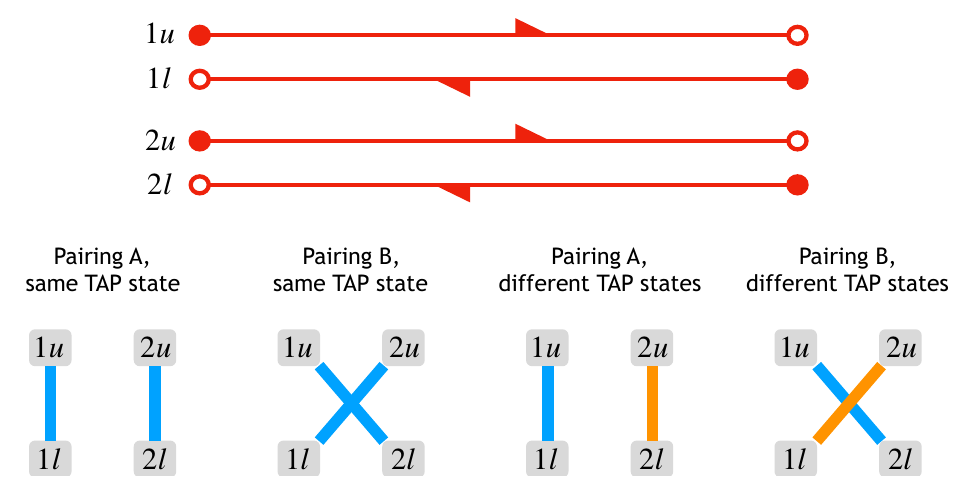
Figure 5 . Graphical representation of the various saddle point solutions for the n = 2 moment. The four contours — 1 u , 1 l , 2 u , 2 l — are shown at the top. Below are the four varieties of solutions: each upper contour must be paired with a lower contour, but one is free to choose which replicas are paired, and there is further freedom in which TAP state each pair lies within (blue and orange lines indicate two different TAP